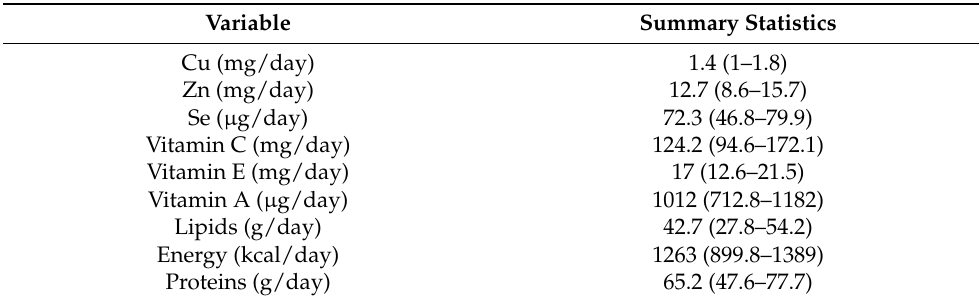
Table 3. Daily nutritional intakes in vitamins, trace elements and lipids in COVID-19 patients (N = 9) hospitalized in ICU. Data are expressed as median (P25–P75).